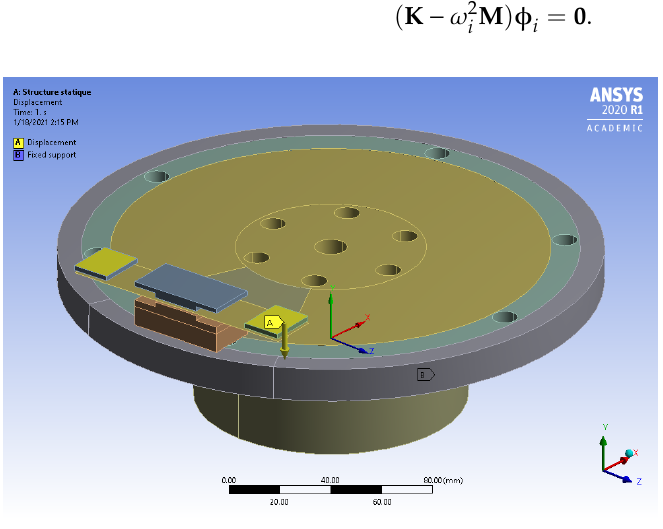
Figure 8. Boundary conditions for static equilibrium analysis.